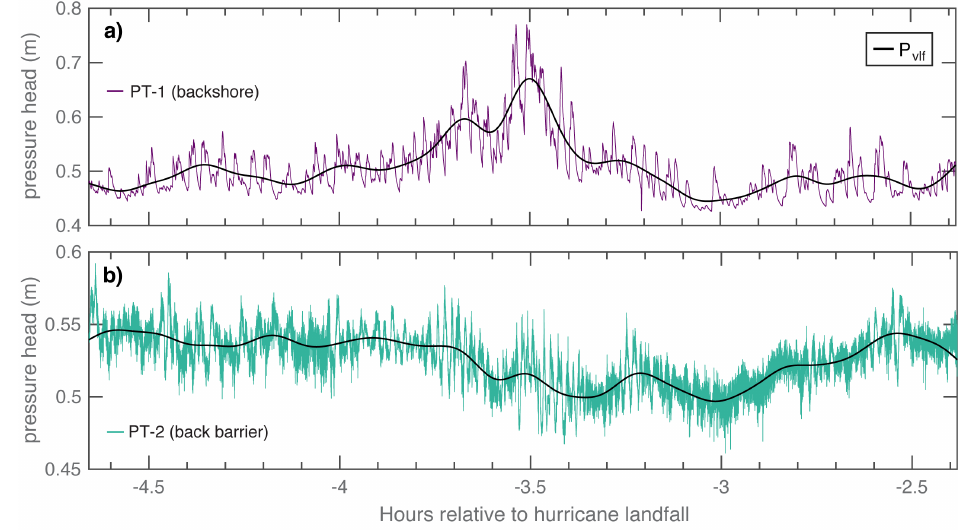
Figure 6. Pressure head P recorded over ∼ 2 h in ( a ) the backshore (PT-1) and ( b ) back barrier (PT-2) at Matagorda Peninsula during overwash. Time series are low-pass filtered (cutoff frequency of 0.003 Hz) to highlight VLF variations in pressure head. Note the different vertical plot scales in ( a , b